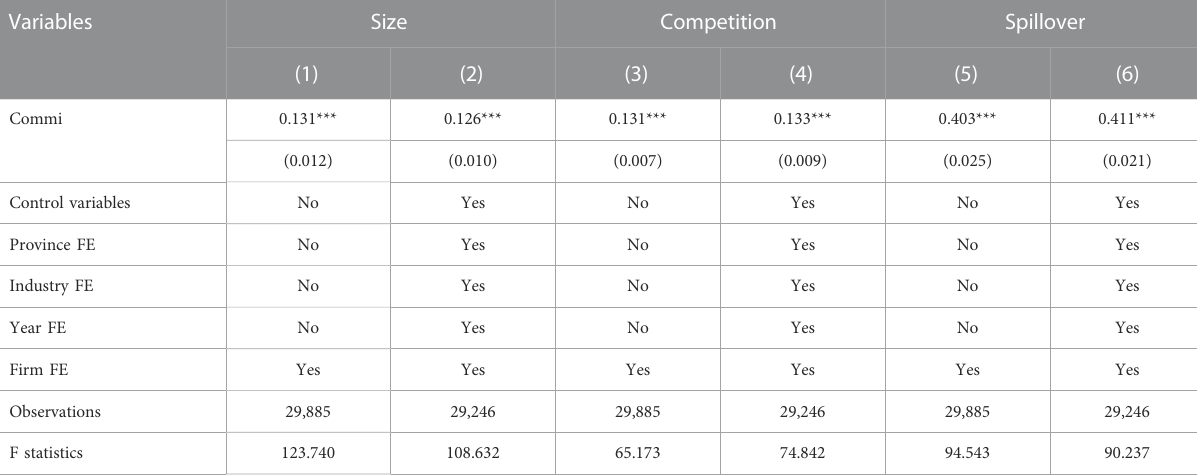
TABLE 7 The mechanism of the impact of commodity market